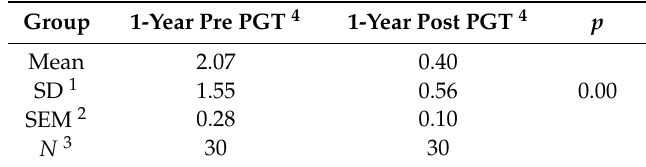
Table 4. Number of times medical emergency services were accessed: mirror analysis.